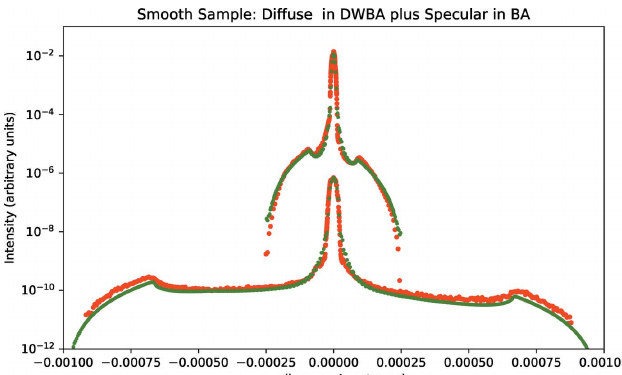
Figure 10 Smooth sample: rocking data (red) and calculated fit (green) for both q z settings of 0.05 and 0.10 A˚ (cid:2) 1 . The offset between the two q z cases is arbitrary and chosen for clarity.